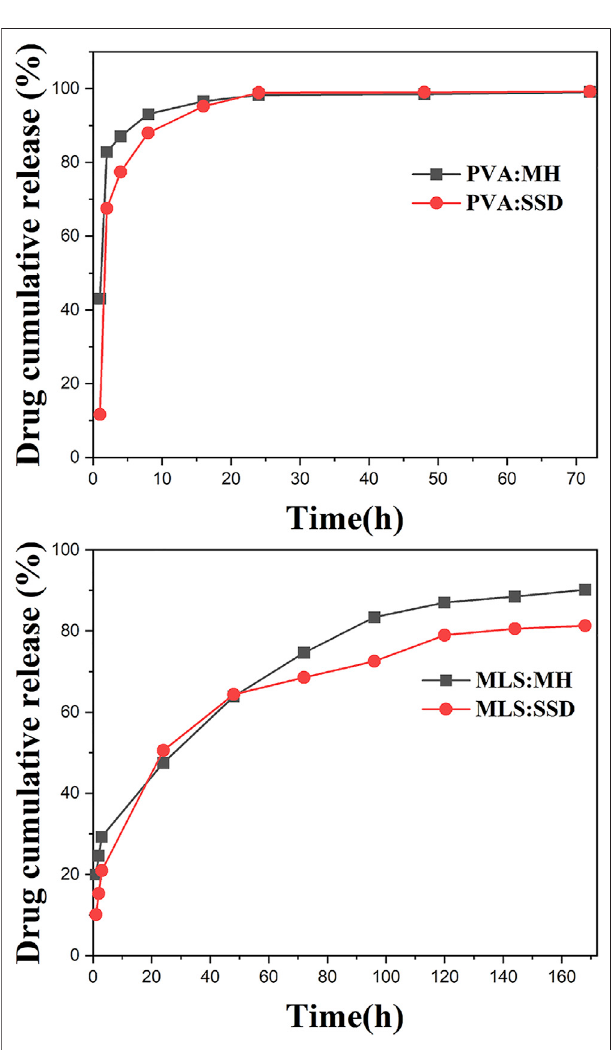
FIGURE 9 | Drug release curves of PVA:MH, PVA:SSD, ML-S:MH, and